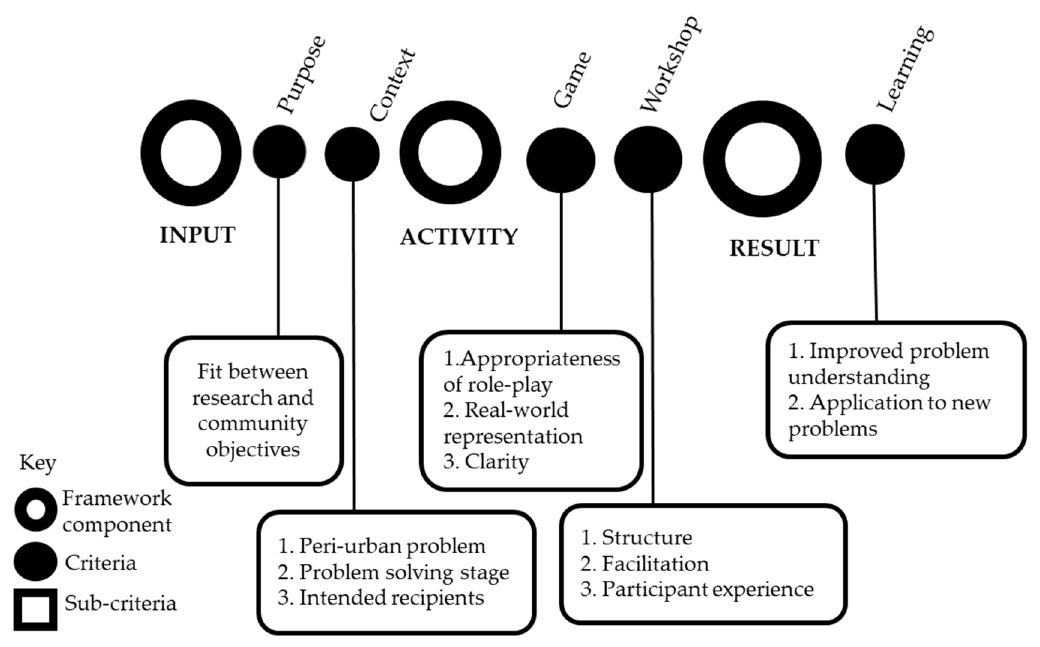
Figure 3. Evaluation design (adapted from [33–35] ).